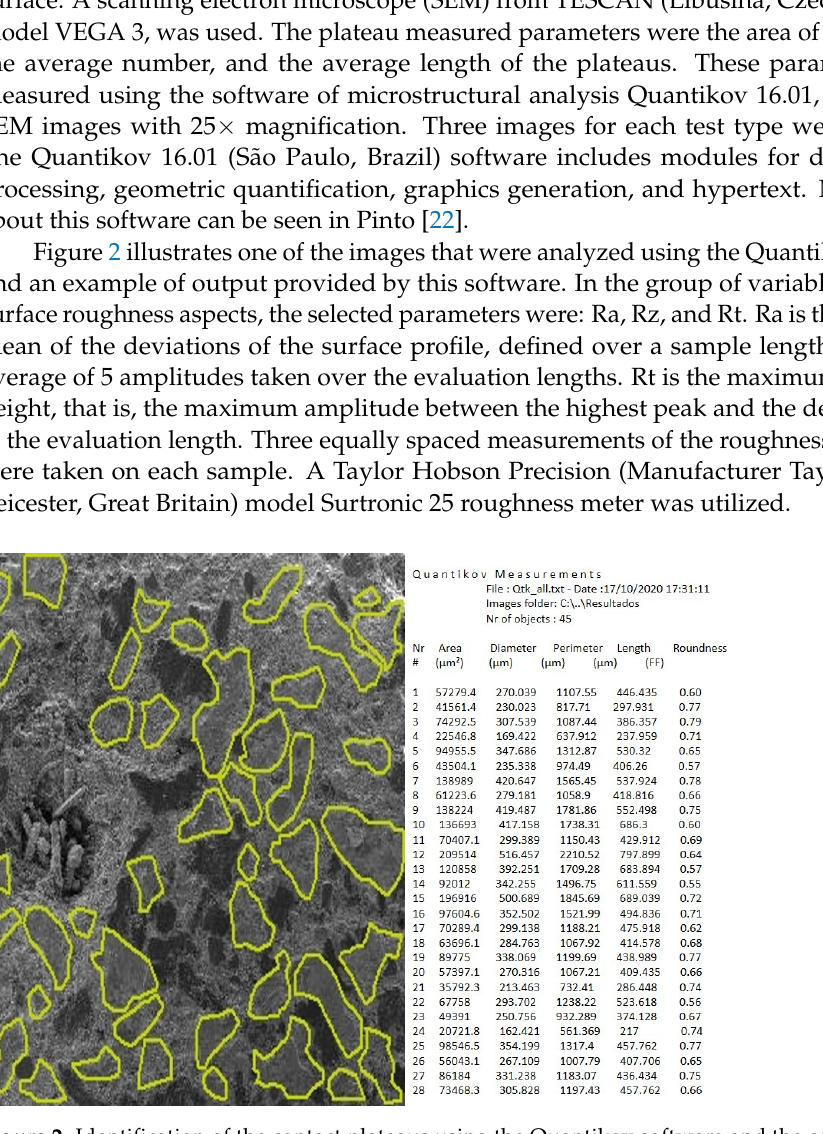
Figure 2. Identification of the contact plateaus using the Quantikov software and the output with the generated geometric